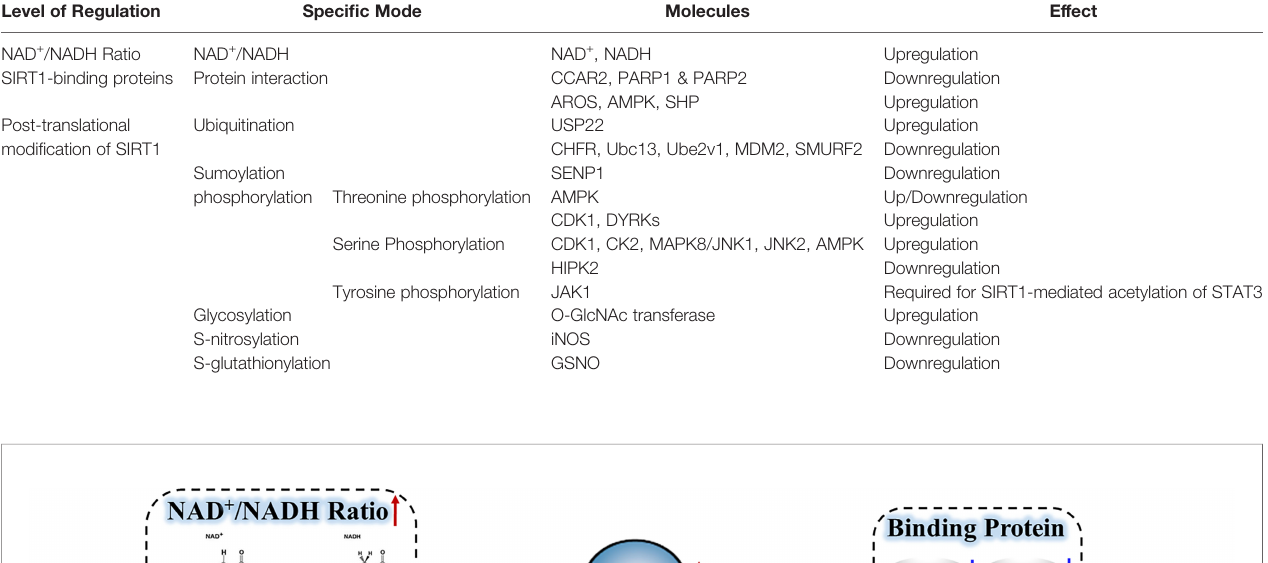
TABLE 2 | Functional regulation of SIRT1